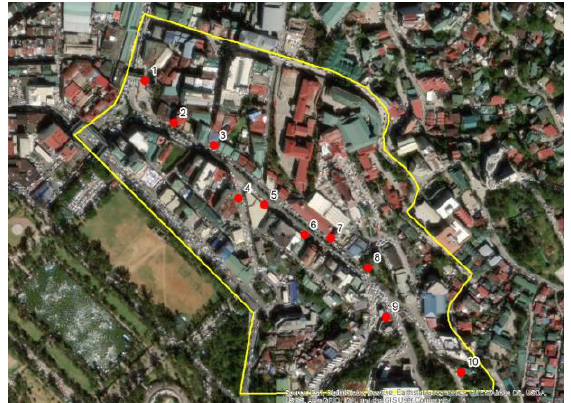
Figure 1. Lower Session Road, Baguio City, bounded by the simulation boundary. The red dots indicate the locations of the 10 receptors with in-situ air temperature measurements.